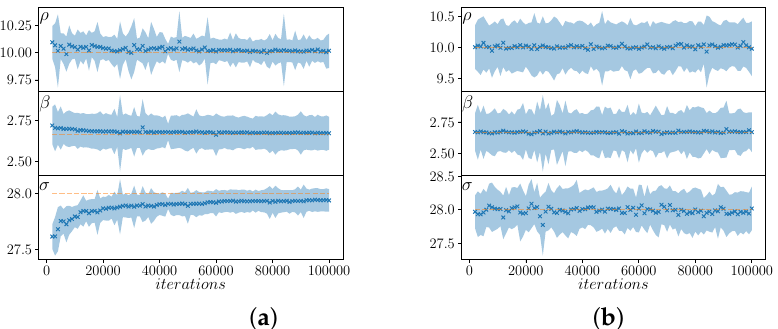
Figure 9. Estimation (x) and standard deviation (blue area) of the parameters computed using the first half of the ensemble ( a ) with and ( b ) without cross-over. The true values are also shown (dotted orange